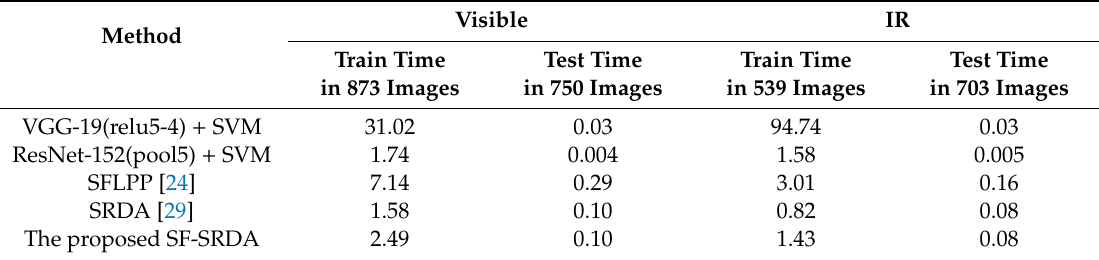
Table 4. Time consume among SF-SRDA and the base-line methods in the coarse-grained partition (second).